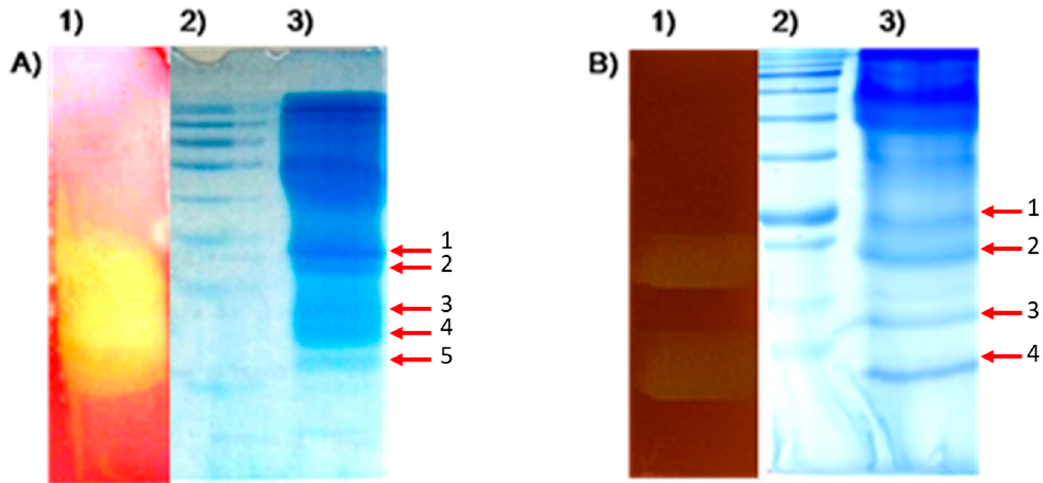
a Protein scores are derived from ion scores as a nonprobabilistic basis for ranking protein hits (http://www.matrixscience.com/help/ interpretation_help.html). Ion score is − 10 Log(P), where p is the probability that the observed peptide match is a random event.